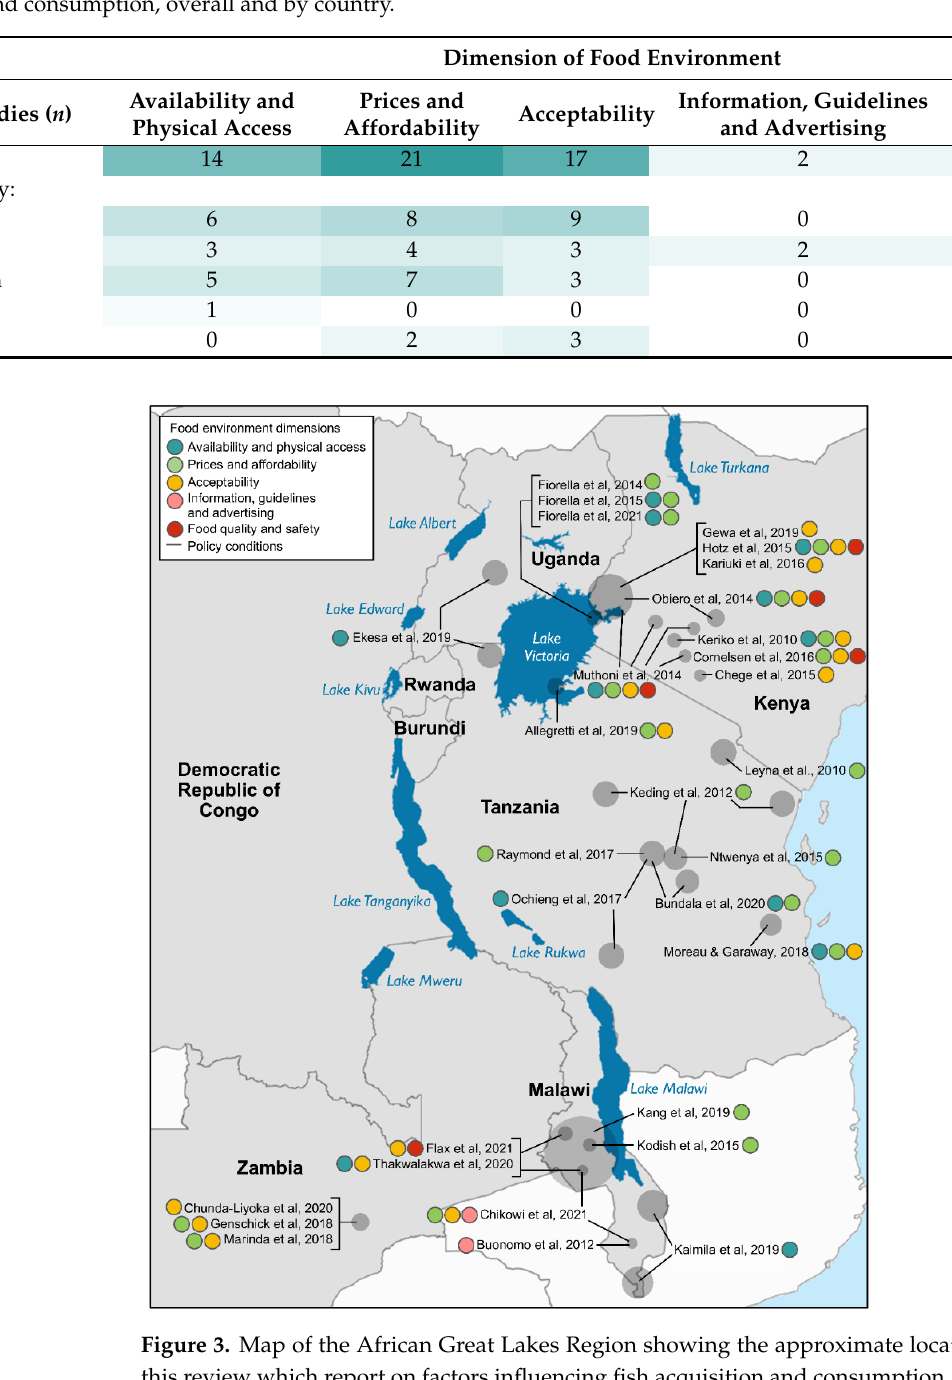
Table 1. Number of studies providing evidence of the influence of each dimension of the food environment on fish acquisition and consumption, overall and by country.